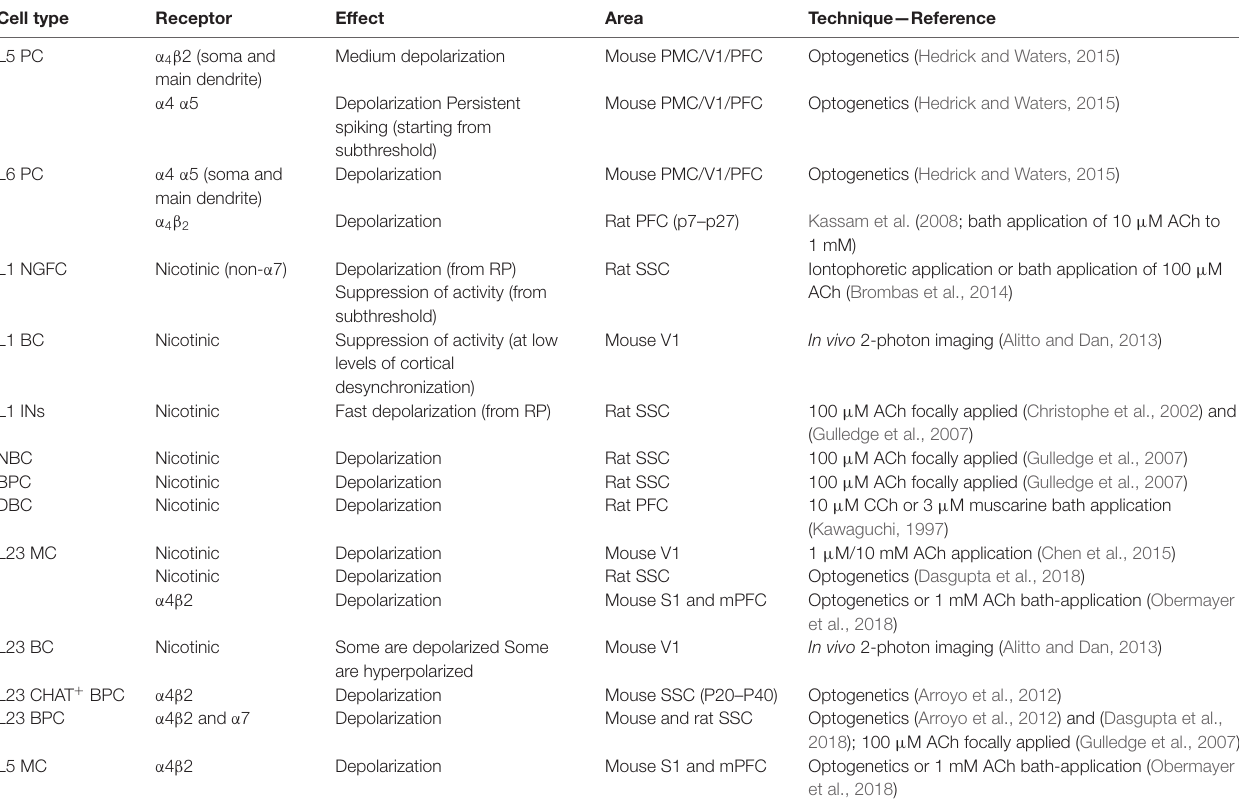
TABLE 2 | Effect of nAChRs activation on membrane potential in various neocortical cell types.